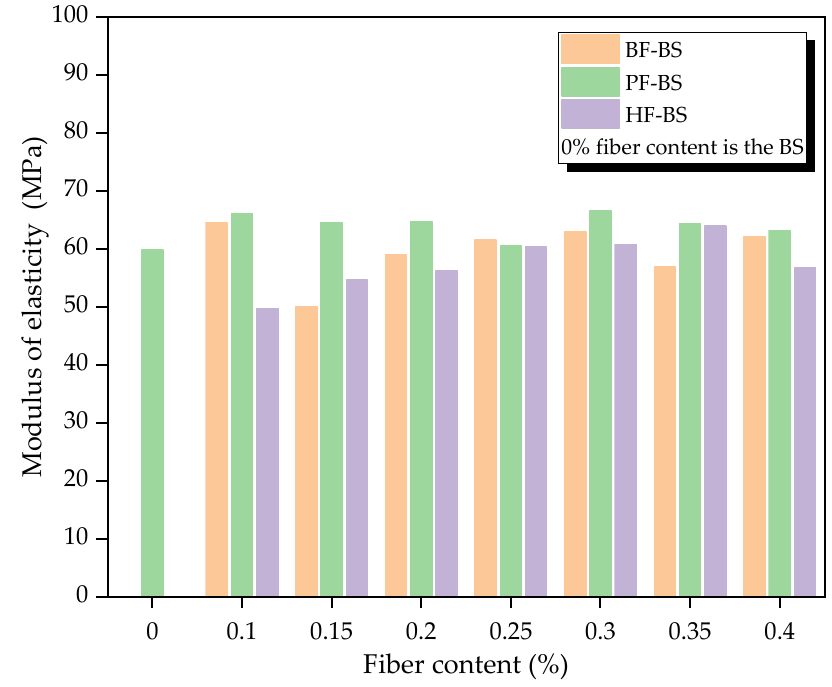
Figure 10. Modulus of elasticity of biocemented sand.